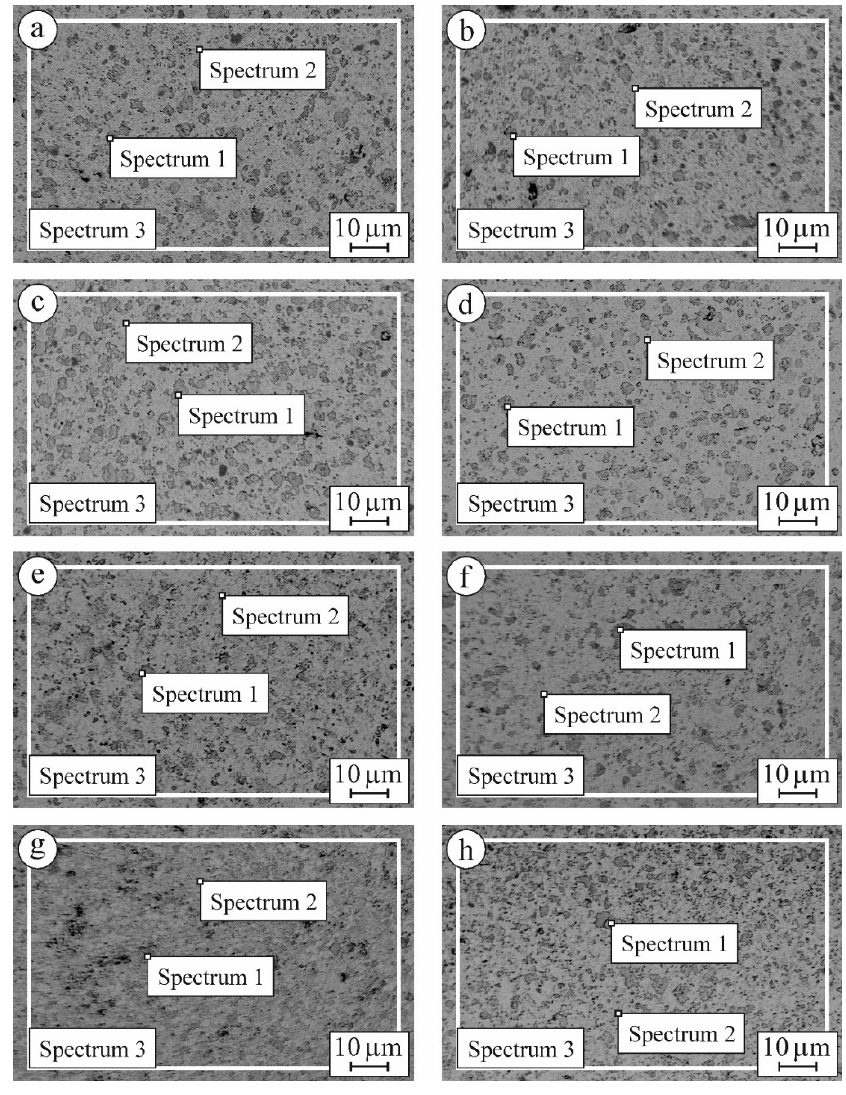
Figure 6. SEM microstructures (BSD images taken at a low magnification) of specimens of ( a ) 6YSZ-1450, ( b ) 6YSZ-1500, ( c ) 6YSZ-1550, ( d ) 6YSZ-1600, ( e ) 7YSZ-1550, ( f ) 7YSZ-1600, ( g ) 8YSZ-1550, and ( h ) 8YSZ-1600 ceramics with corresponding EDX spectra locations (Table 2). Table 2. The percentage (wt%) of the main chemical elements (oxygen, yttrium, and zirconium) present in local areas (spectrums 1 and 2) and in general (spectrum 3) according to the local and general EDX analyses of the investigated material variants (see Figure